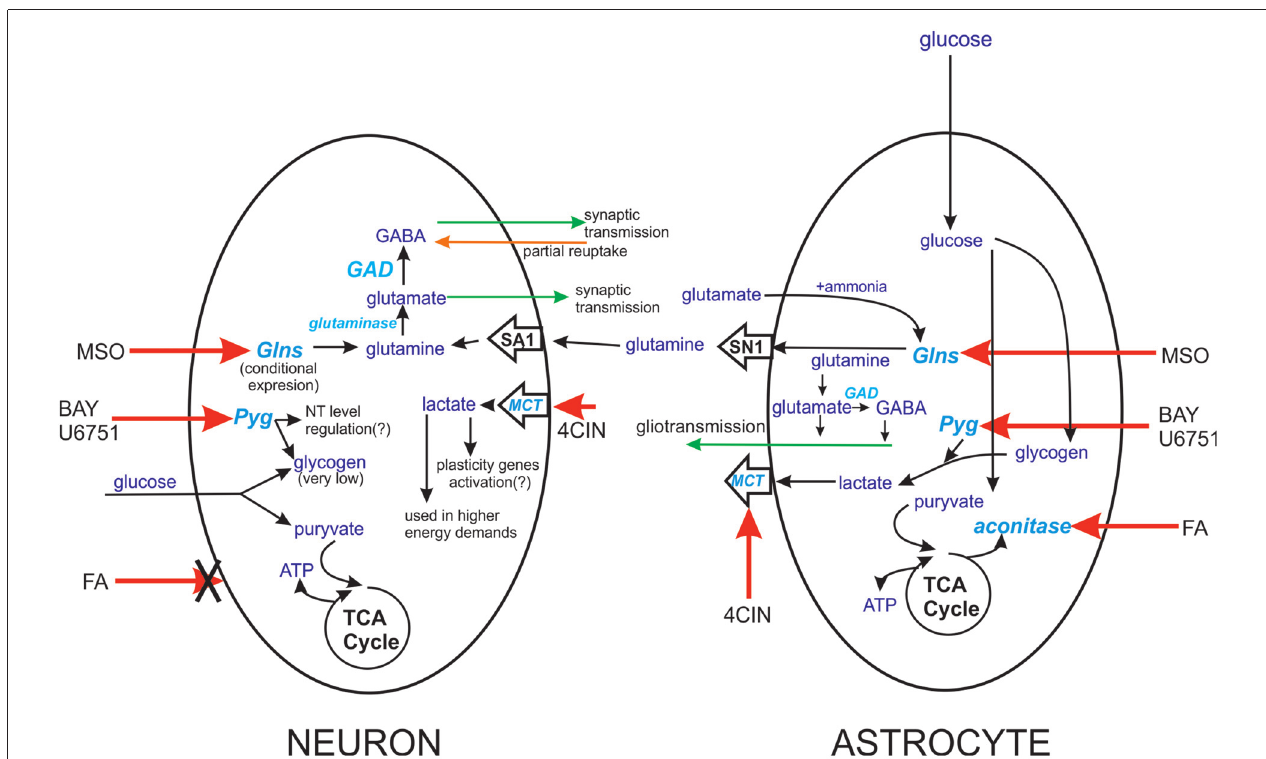
FIGURE 1 | Schematic representation of the site action of tested compounds. Action sides of tested compounds are pointed with red arrow, aconitase-FA, monocarboxylates transporters (MCT’s)-4CIN, Pyg-BAY U6751, Glsn-methionine sulfoxide (MSO). The differences between action sides of these compounds are severe. In case of FA, we can only influence astrocytes since this agent can’t be taken by neurons. Similar but different is Glns case, expression of this enzyme in neurons is highly connected with deprivation of neurons from glutamine delivery. In case of astrocytes Glns is constitutively expressed by them and can be even considered as marker enzyme for CNS cells. Glutamine is delivered from astrocytes to neurons through SN1 and SA1 transporters, expressed in astrocytes and neurons, respectively. Factor that differentiate neuronal Pyg from its astrocytic counterpart is level of glycogen in these cells. Lastly actions of MCT’s in astrocytic-neuron cross talk. MCT’s localized in neurons are responsible for monocarboxylate compound intake, and astrocytic ones have delivery